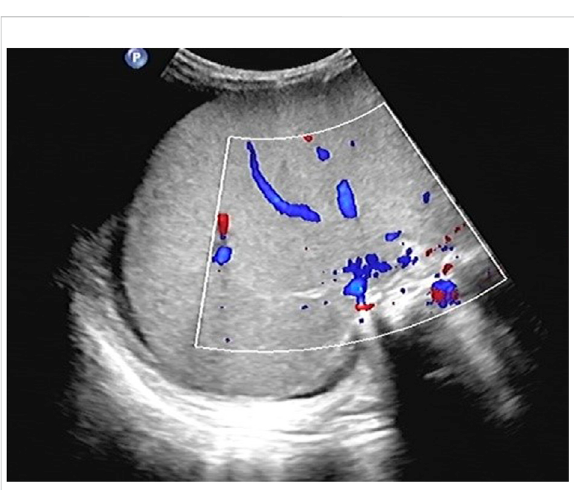
FIGURE 2 Results of abdominal ultrasound examination suggest ascites and right hepatic vein occlusion. There was an anechoic area around the liver, and the right hepatic vein lumen was not clearly displayed, and there was no obvious blood fl ow signal in the right hepatic vein course